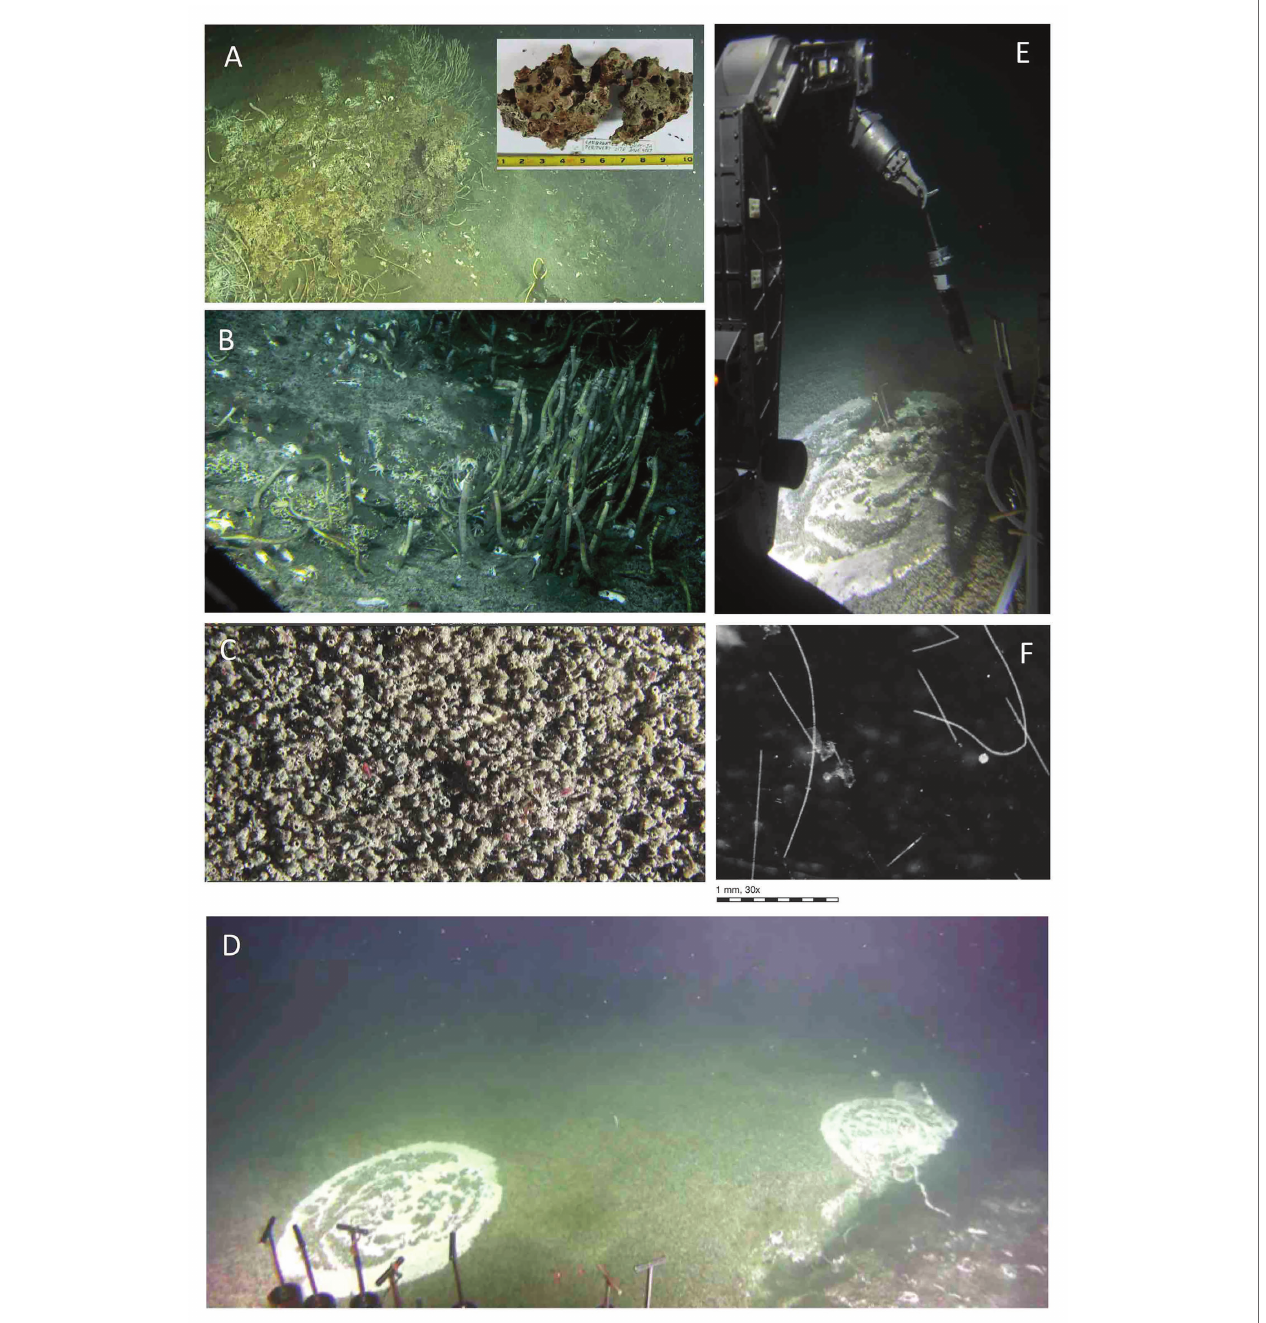
FIGURE 3 | Benthic fauna at Octopus Mound sampling sites. (A) Seafloor carbonate concretions with tube worms at the “active site” near the base of Octopus Mound. Insert, carbonate sample collected at this location during Alvin dive 4867. (B) Seep community with different types of tubeworms resembling Lamellibrachia , galatheid crabs, and clam shells. The original image was underexposed and had to be digitally manipulated, resulting in over-emphasized steel-blue hues instead of olive-green and brown tones. (C) Close-up view of ampharetid worm carpet, with pink worms protruding from several worm tubes. Overall view ~10 × 20 cm; video still from Alvin’s bottom camera. (D) Sedimented Hydrate mound, overgrown with an extensive mat of ampharetid worms and circular spots of Beggiatoaceae mats. At the massive fracture to the right, the mat-covered sediment is ca. 0.5 m elevated, suggesting rising hydrate underneath. The Beggiatoaceae mat to the left was sampled with Alvin push cores. (E) Coring the Beggiatoaceae mat on top of the hydrate mound during dive 4867, the “hydrate site.” The bottom of the freshly collected core contains white gas hydrate (presumably methane hydrate) that dissipates during transport to the surface. (F) Individual Beggiatoaceae filaments recovered from the hydrate mat are viewed through a dissection binocular. Filament diameters are in the range of 100–160 μ m, consistent with large, colorless Beggiatoaceae observed previously in Guaymas Basin (McKay et al., 2012; Teske and Salman, 2014). Images A–E courtesy of the Alvin group, WHOI; dissection scope image of filaments by Barbara